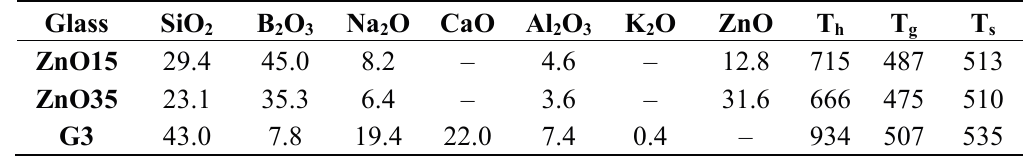
Table 3. Chemical composition (mol %) and thermal